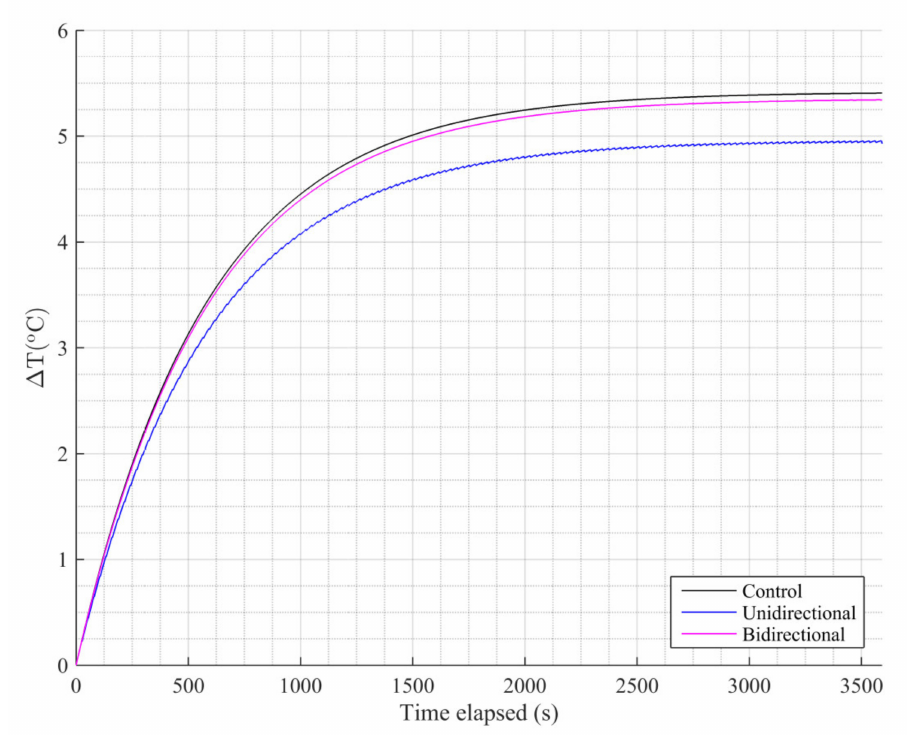
Figure 6. Temperature increase at the center of the tumor (target) volume during treatment. The MNPs’ heating efficiency was reduced when applying either protocol, because the magnetic field they were exposed to was not constantly the maximum possible (on